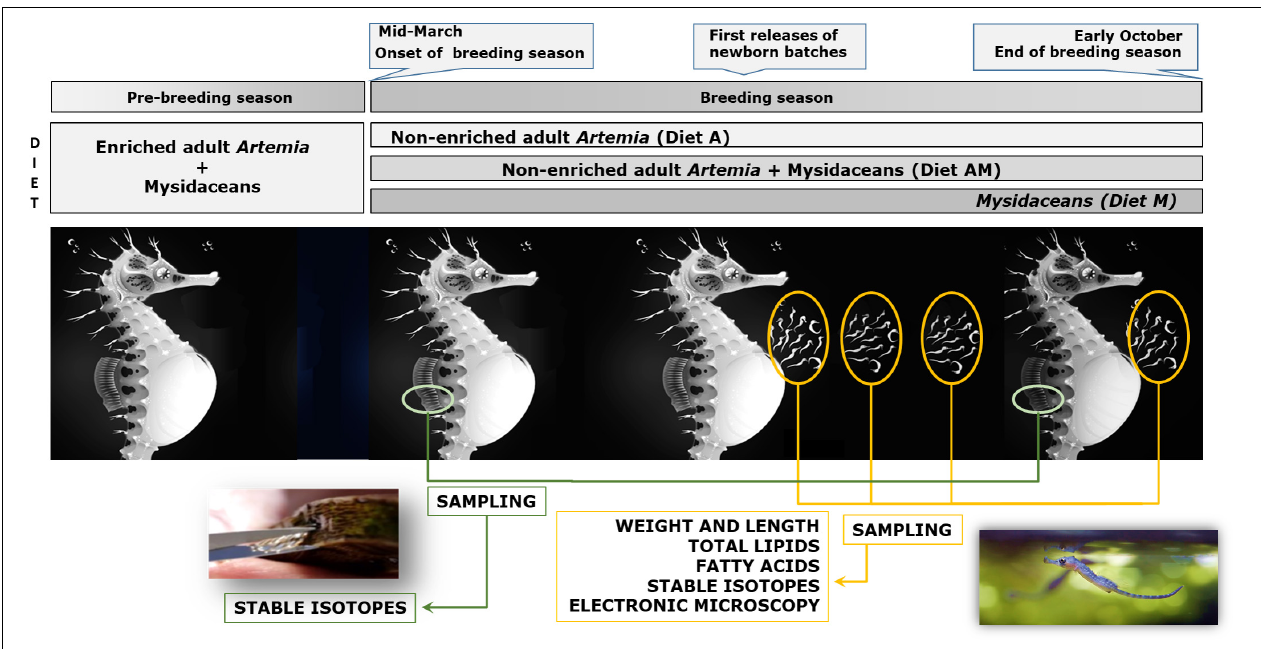
FIGURE 1 | General scheme of the experimental framework (breeders fed on diets A, AM, and M) and sampling (dorsal fin and newborn). Seahorse illustration by Sergio Picazo Ferro (https://sergiopicazo.com/).